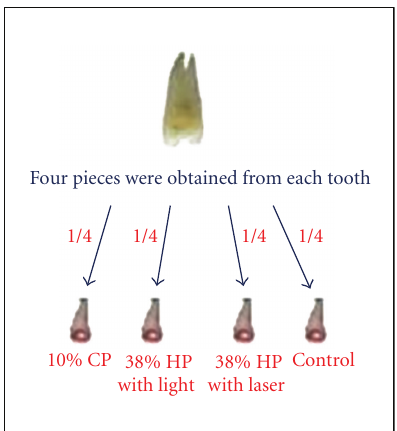
Figure 1: The tooth was divided buccolingually or buccopalatinally into two parts and these halves were then sectioned longitudinally into two parts. Four specimens were obtained from each